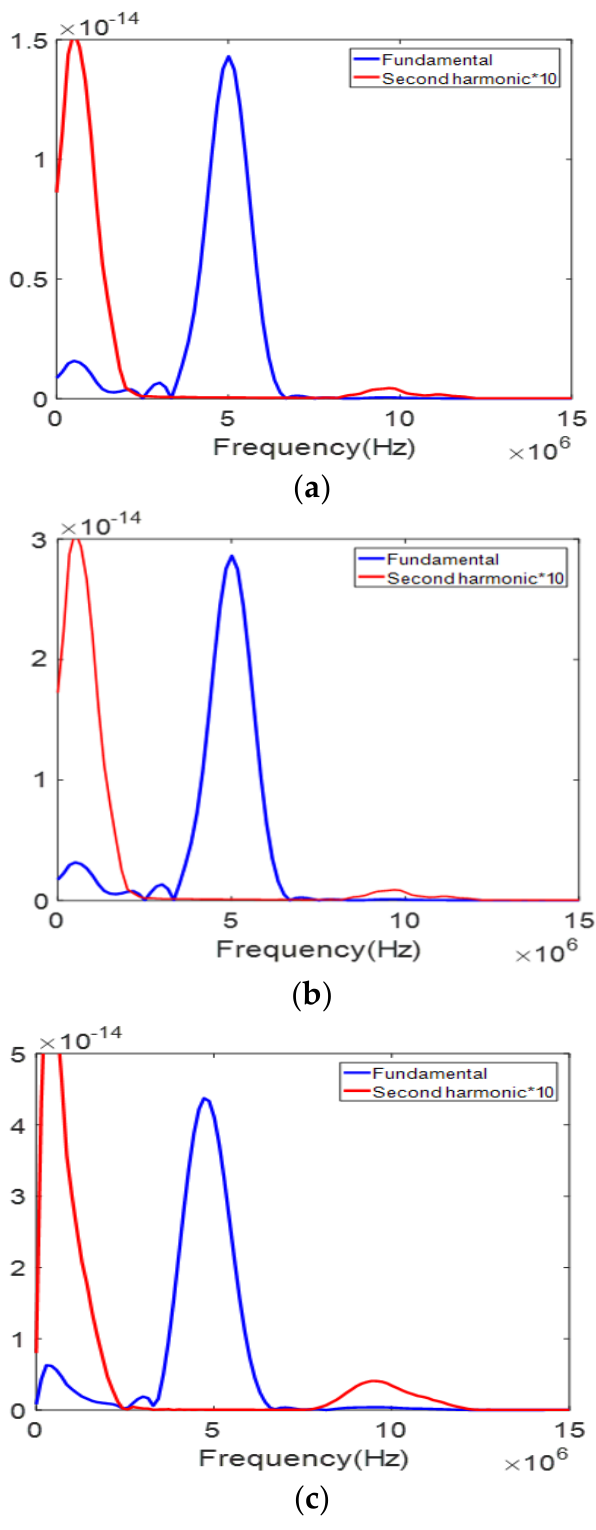
Figure 11. The received signal spectrum for three different APAT cases in Figure 10: ( a ) Case A13; ( b ) Case B13; and ( c ) Case C13.